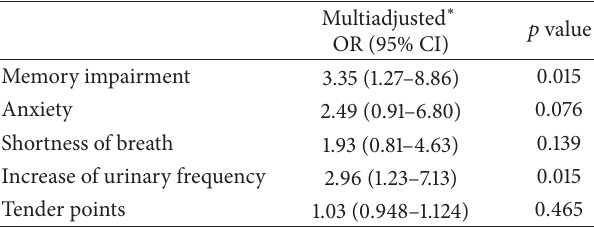
Table 5: Fibromyalgia manifestations independently associated with overweight/obesity by logistic regression